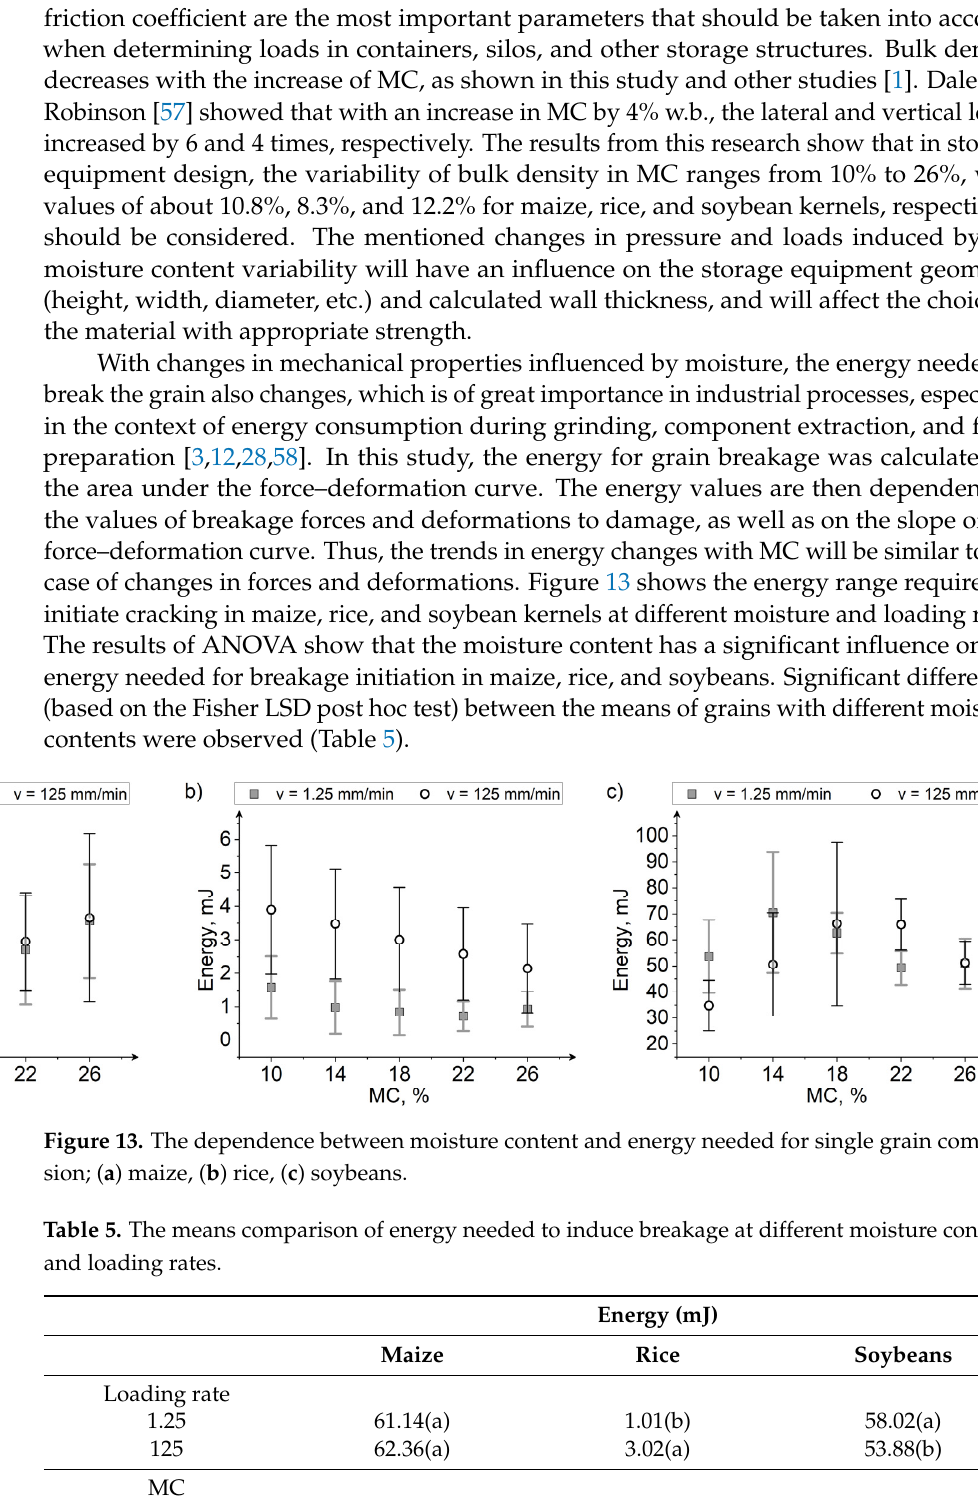
Table 5. The means comparison of energy needed to induce breakage at different moisture contents and loading rates.